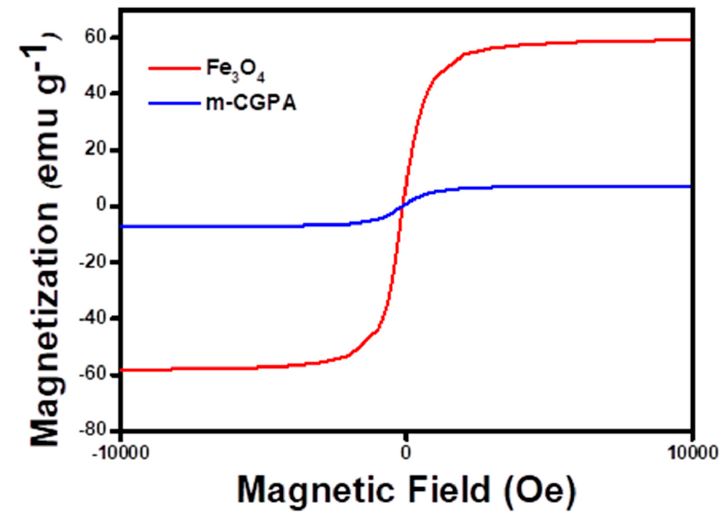
Figure 6. Magnetic hysteresis loop of m-CGPA in comparison with Fe 3 O 4 .